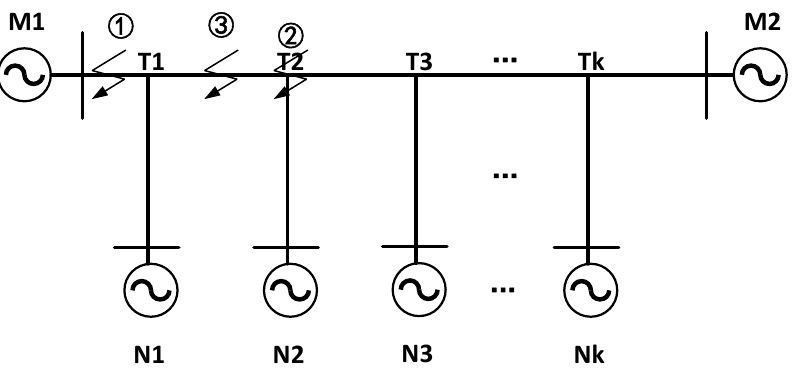
Figure 5. Multi-branch grid-connected line.